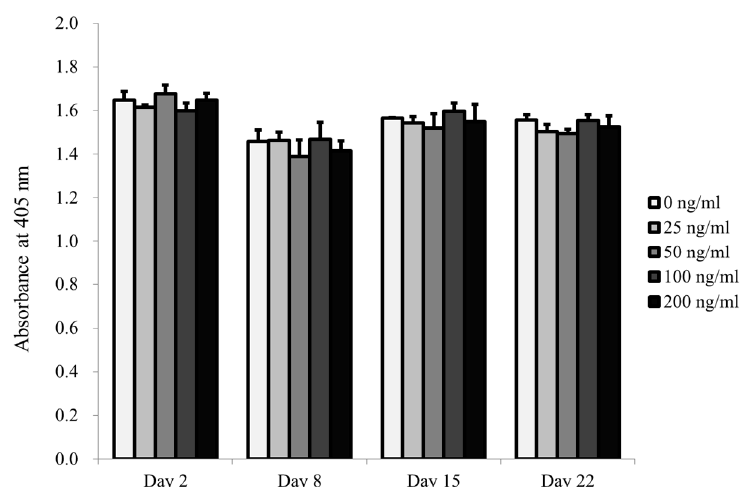
Figure 5. Graphical representation of alkaline phosphatase activity results on Days 2, 8, 15, and 22.